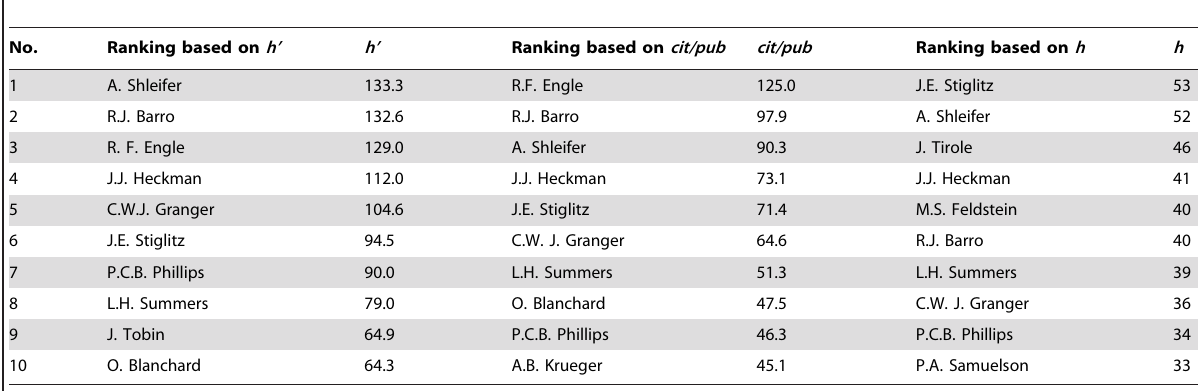
No. Ranking based on